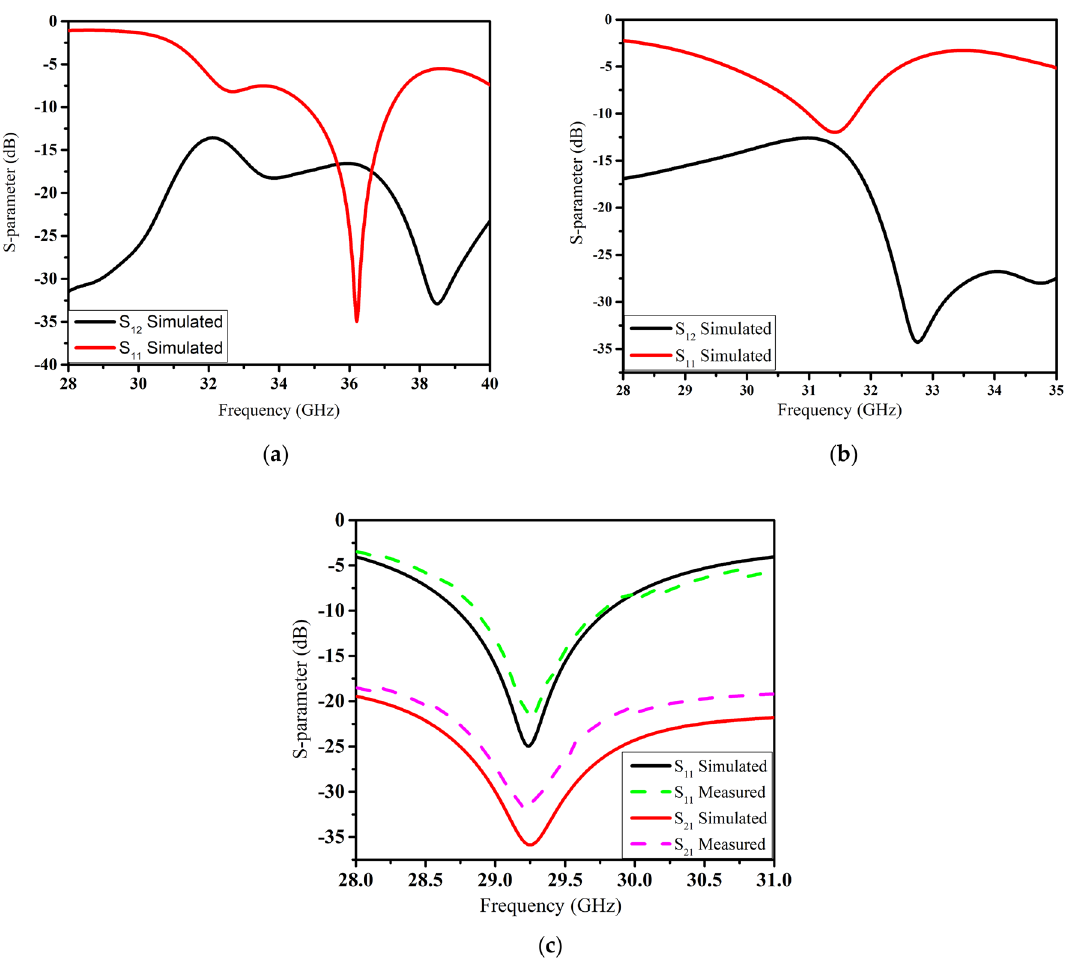
Figure 4. S-parameter of ( a ) straight elements ( b ) bend elements ( c ) and proposed elements MIMO antenna.